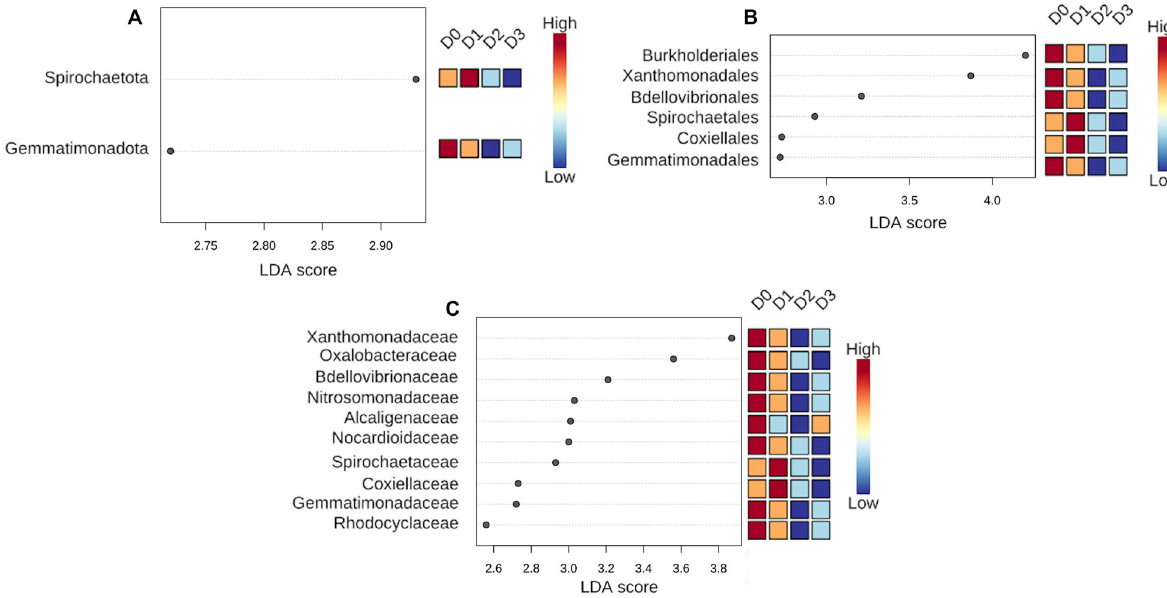
Fig. 5 Linear discriminant analysis effect size (LEfSe) of all scenarios. Phylum, order and family taxonomic levels are respectively shown in panels ( A , B and C ). LEfSe threshold of 2 (on a log 10 scale) and a significance threshold of 0.05 were set. p values were adjusted for false discovery rate (FDR) method